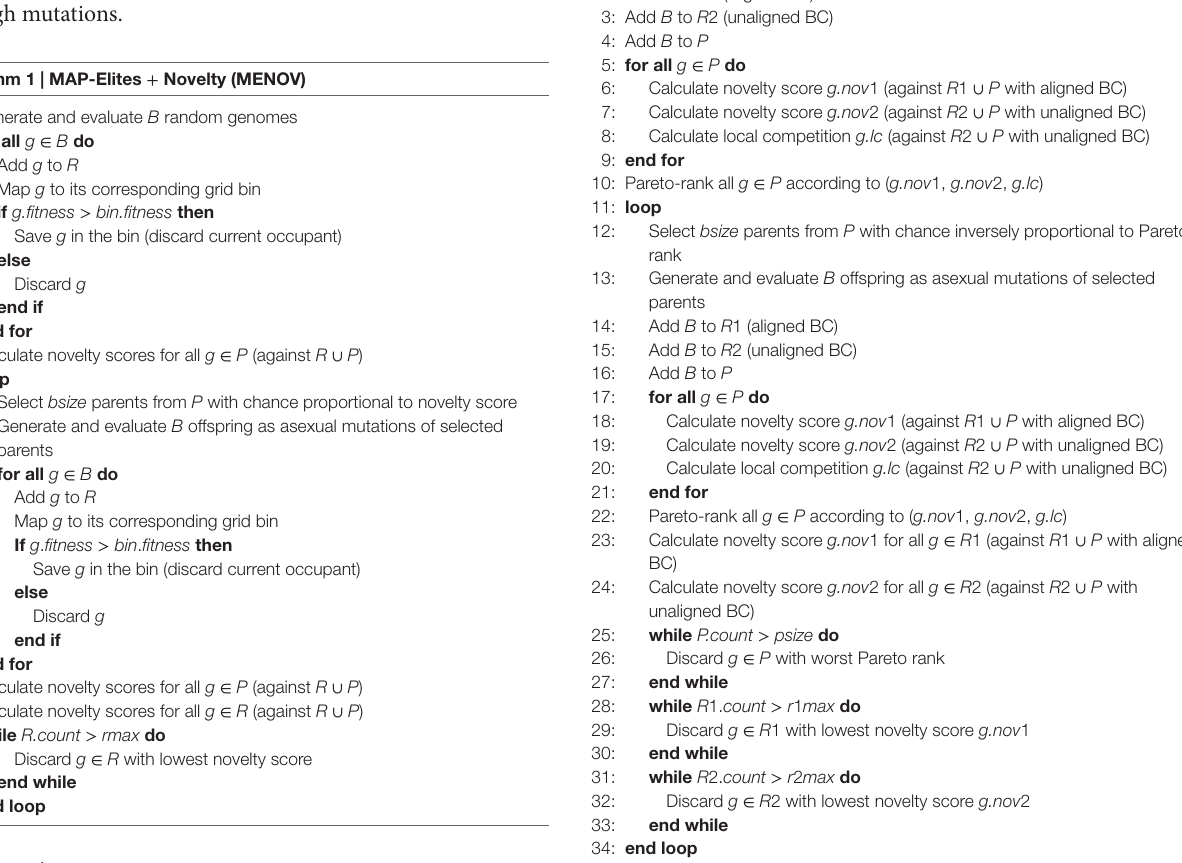
algorithm 2 | MaP-elites + Passive genetic Diversity (MePgD)